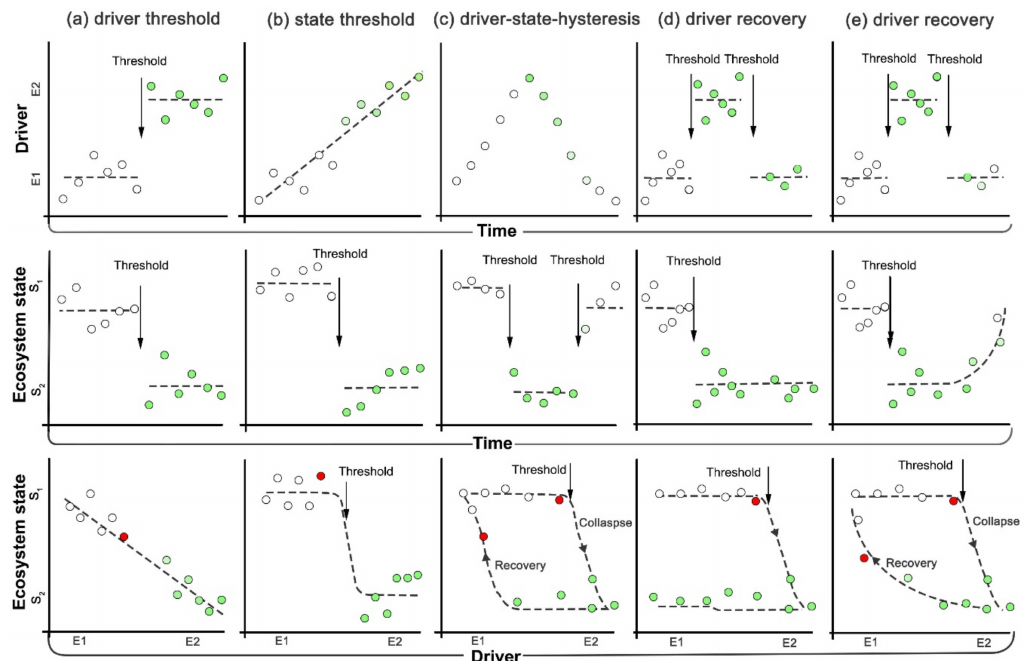
Figure 1. Conceptual models of alternative types of regime shifts and threshold transitions ( a – c ) after Andersen et al. [18] and ( d , e ) after Jeppesen et al. [19]). White and green dots distinguish ecosystem states S 1 and S 2 , respectively. Red dots identify threshold points of abrupt and persistent change in driver or ecosystem state, and arrows identify the direction of change. The three rows display the driver (top row) and ecosystem (middle row) state developing through time and the ecosystem response to the driver (bottom row) with consequences for ecosystem